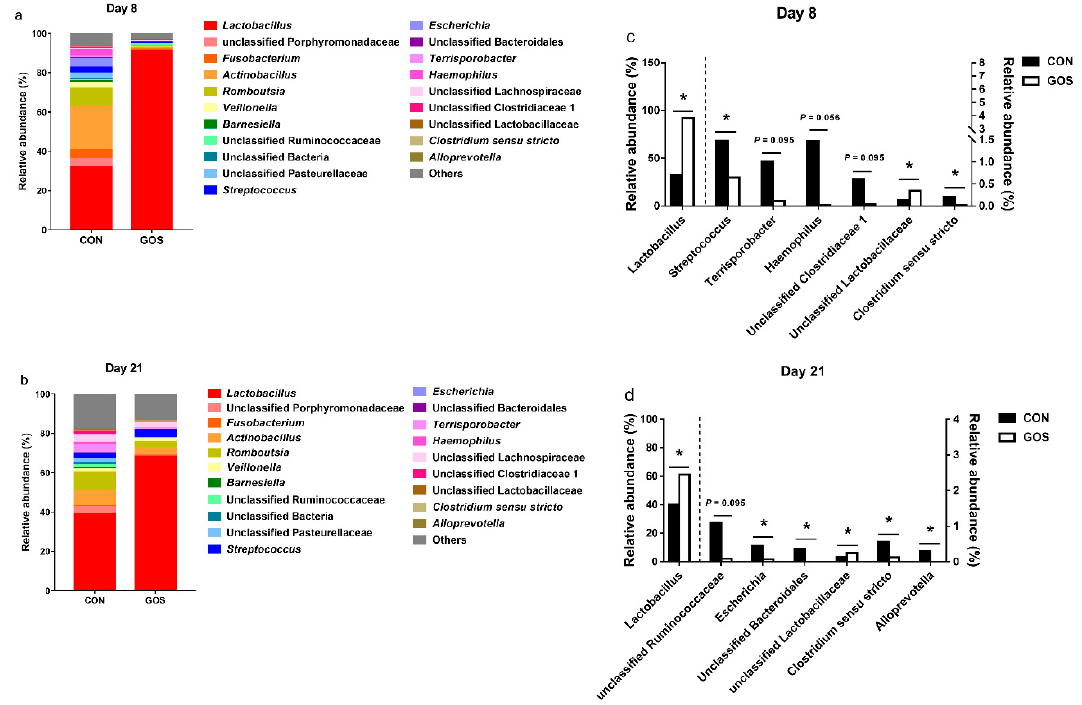
Figure 4. Effects of early-life galacto-oligosaccharides (GOS) intervention on the genus-level composition. ( a , b ) The genus-level composition of average relative abundance ileal microbiota in suckling piglets, ( c , d ) the changes in the abundance of bacterial genera found in ileum. The values are expressed as the medians, with five piglets per group. The “ * ” indicates a significant difference ( P < 0.05) between the CON and GOS group (Mann–Whitney U -test). CON, a control group; GOS, a galacto-oligosaccharides intervention group.